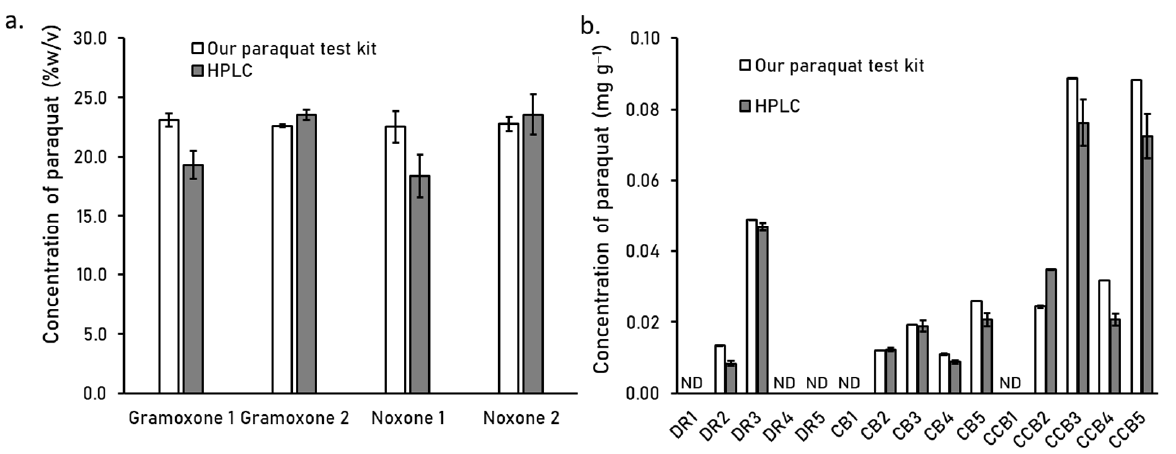
Figure 9. Paraquat content obtained from the developed test kit and HPLC for ( a ) commercial pesticide solutions and ( b ) vegetable samples. ND: not detected.